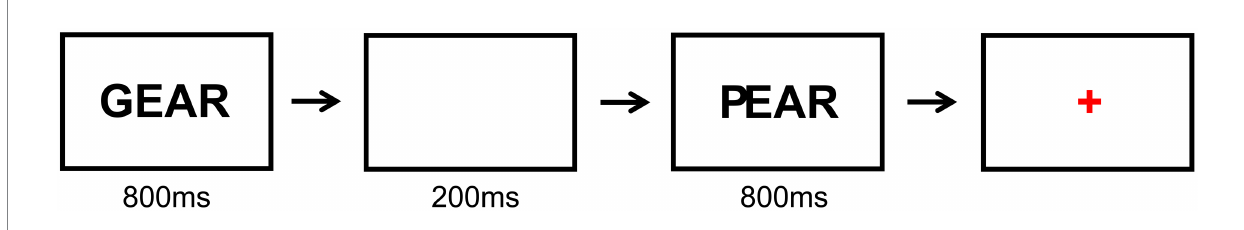
FIGURE 1 Illustration of a condition trial during the rhyme judgement task.